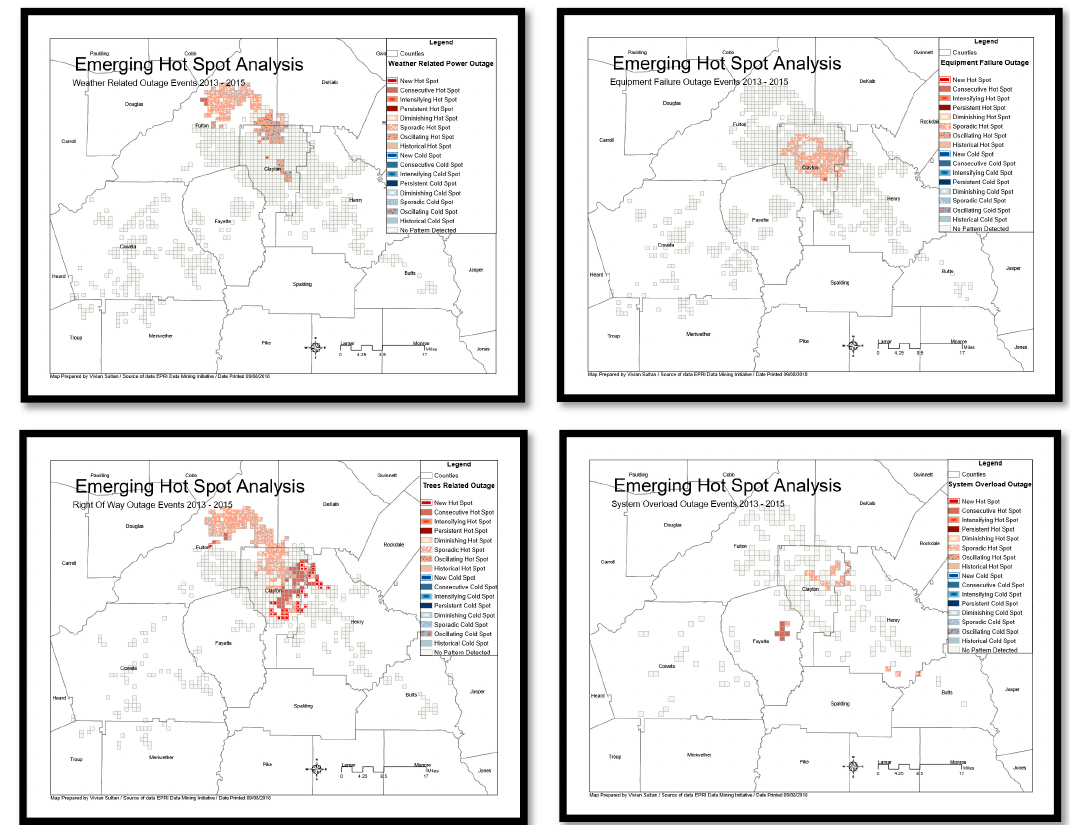
Figure 13. Spatial Analysis Level 2—Emerging Hot Spot Analysis output maps per type of outag13causes. Top left : weather; top right : equipment failure, bottom left : right of way; bottom right : system overload.